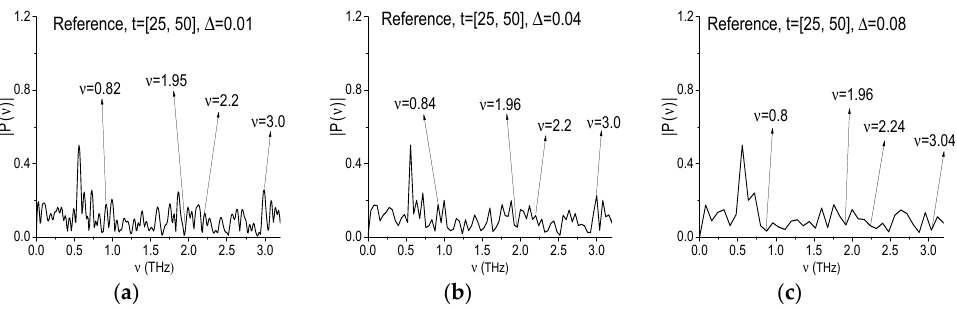
Figure 19. Reference spectrum calculated in the time interval t = [25, 50] with spectral resolution Δ ν = 0.01 THz ( a ), 0.04 THz ( b ), 0.08 THz ( c ). However, in Figure 19c (the spectral resolution is decreased up to Δ ν = 0.08 THz) the Reference spectrum minima (or values closest to minima) appear again at the frequencies close to RDX absorption frequencies ν = 0.8, 1.96, 2.24, 3.0 THz. The same Reference spectrum minima can be seen for the corresponding Chocolate signal spectrum in Figure 18g. corresponding absorption lines of the Chocolate signal at the frequencies ν = 0.82, 1.95, 2.2, 3.0 THz are less than 0.04 THz, which does not correspond to the RDX spectrum (see Figure 10a–c). Let us ν = 0.82 THz is not less than 0.1 THz [3–5]. Therefore, if RDX is present in the chocolate, then we have